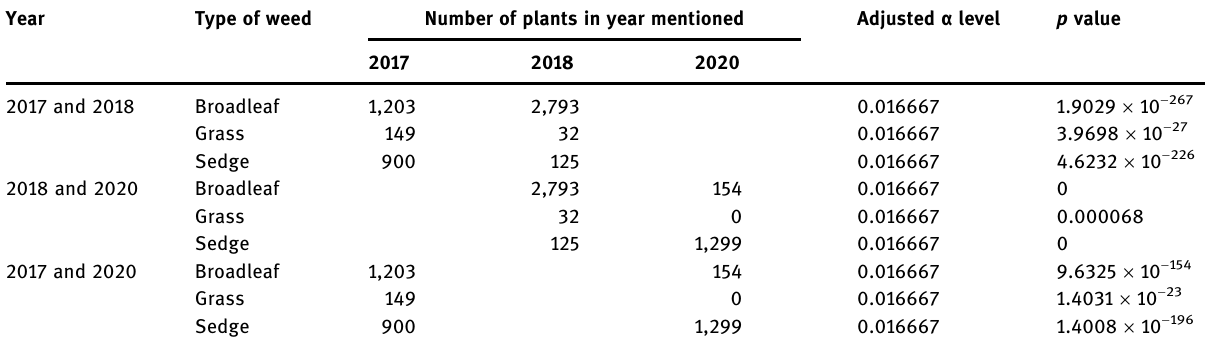
Table 2: A comparison of broadleaves, grasses, and sedges in 2017, 2018, and 2019 using two - proportion z - tests Year Type of weed